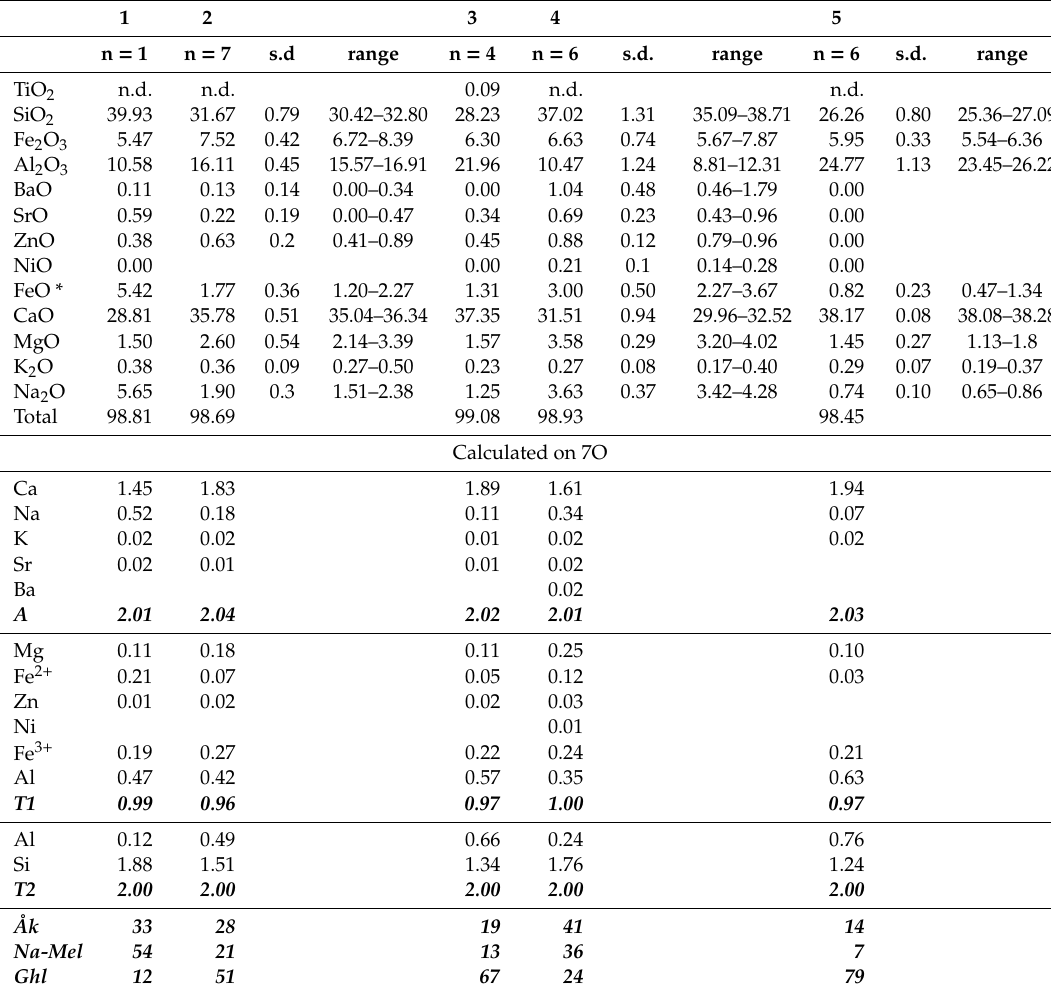
Table 6. Chemical composition of the melilite group minerals from Zuk Tamrur (1–3) and Gurim Anticline (4,5),